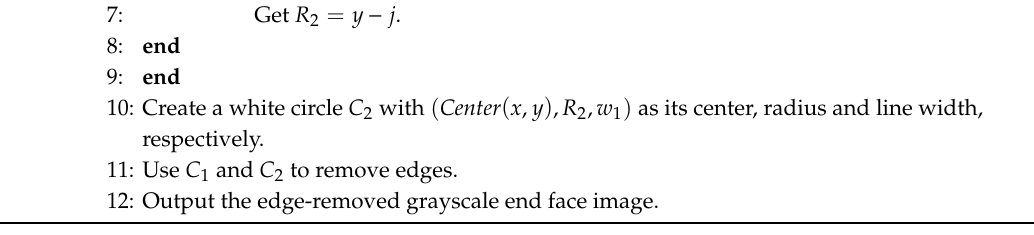
Algorithm 2 Image Edge Removal Algorithm